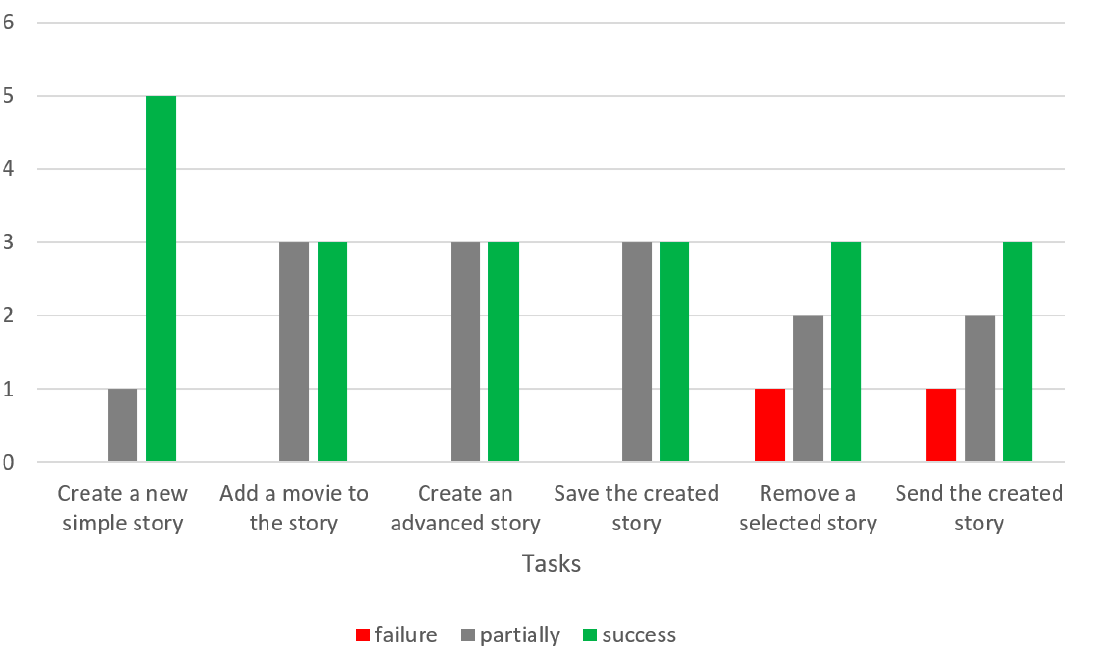
Table 3. Results of the usability test of the Aphastory application.